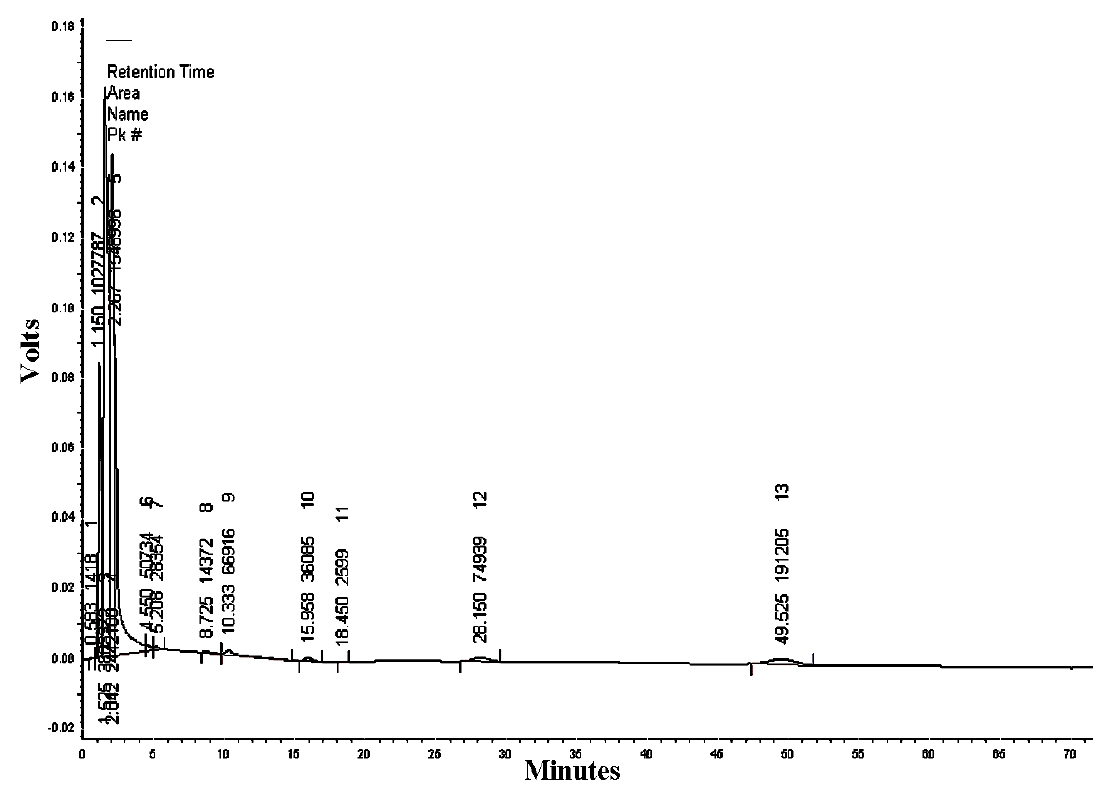
Figure 8. High-performance liquid chromatography/ultraviolet-visible (HPLC/UV-VIS) chromatogram of Ricinus communis leaf ethanol extract monitored at the wavelength of 254 nm.